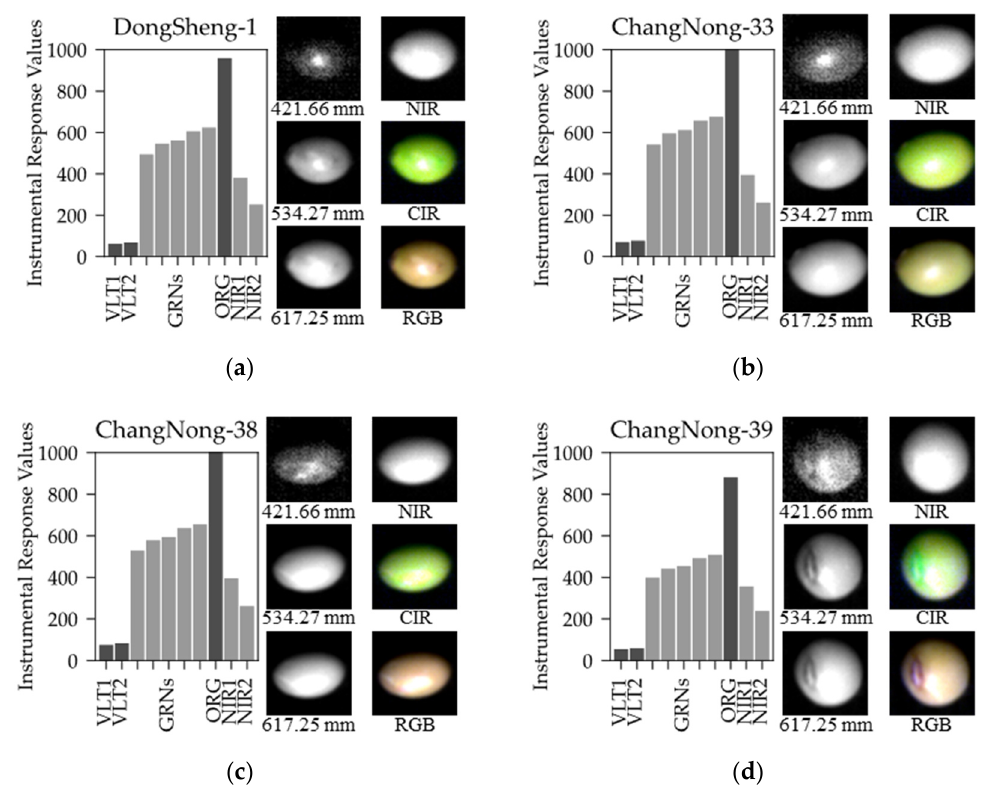
Figure 5. Subset and visual features image for soybeans in this paper. ( a ) DongSheng-1 subset (Label 0). ( b ) ChangNong-33 subset (Label 1). ( c ) ChangNong-38 subset (Label 2). ( d ) ChangNong-39 subset (Label 3)